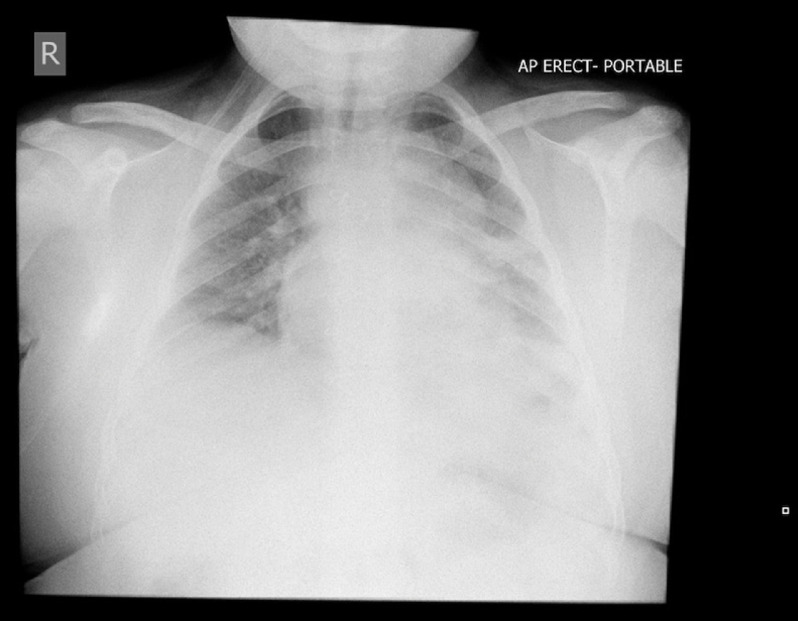
Chest X-ray day 7.